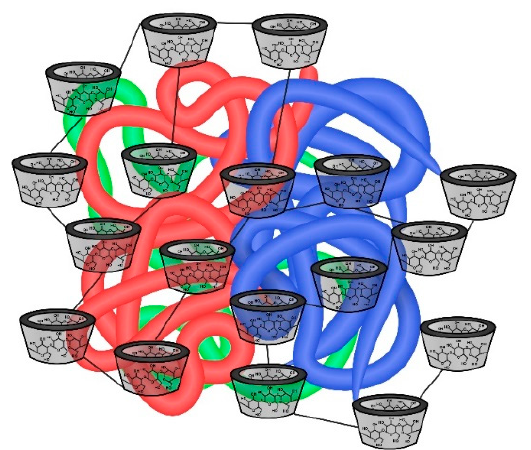
Figure 2. Schematic representation of proteins loaded in CD-NSs. The different chains of the protein are represented in green, red and blue.